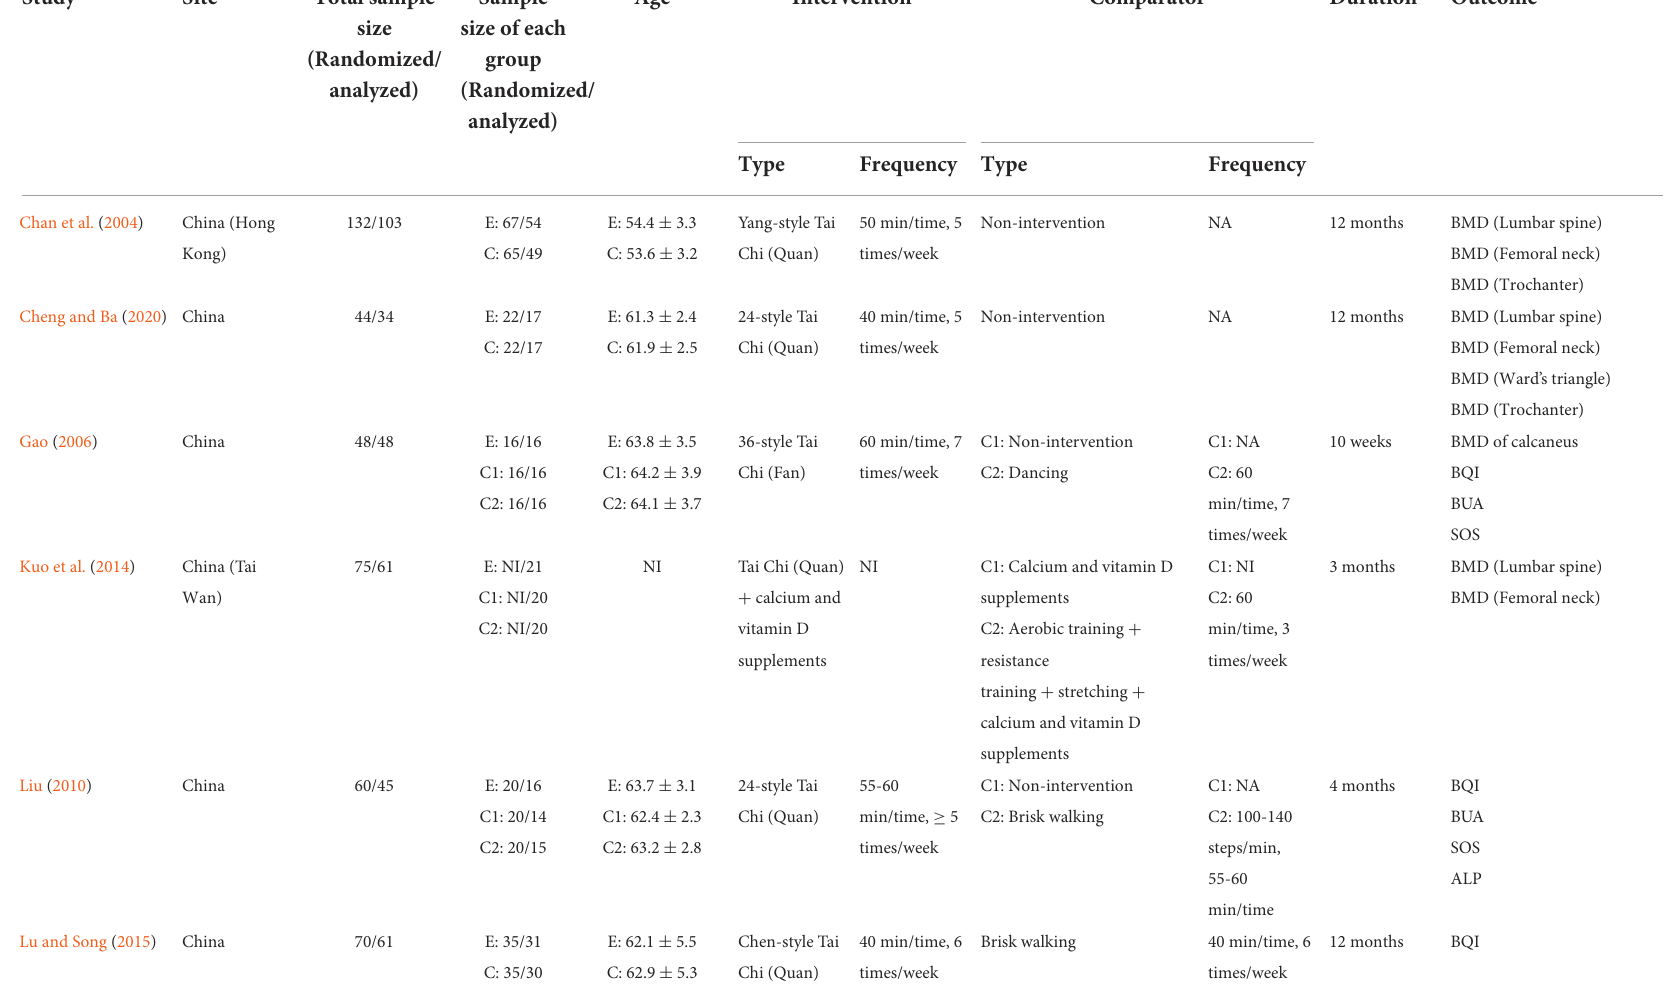
TABLE 1 Characteristics of included